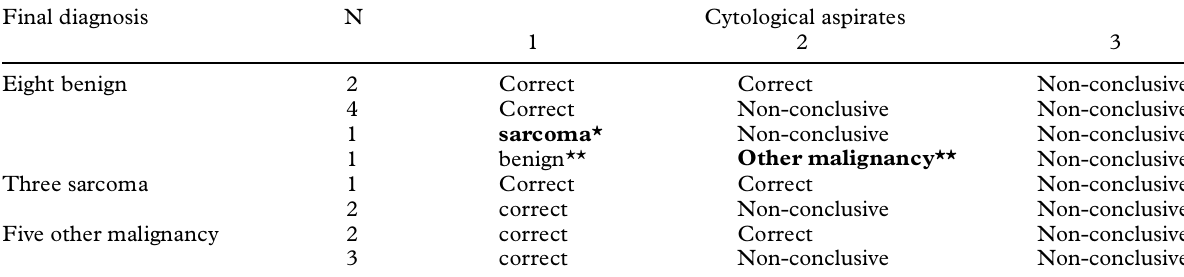
Table 3. Original review: the 16 heterogeneous